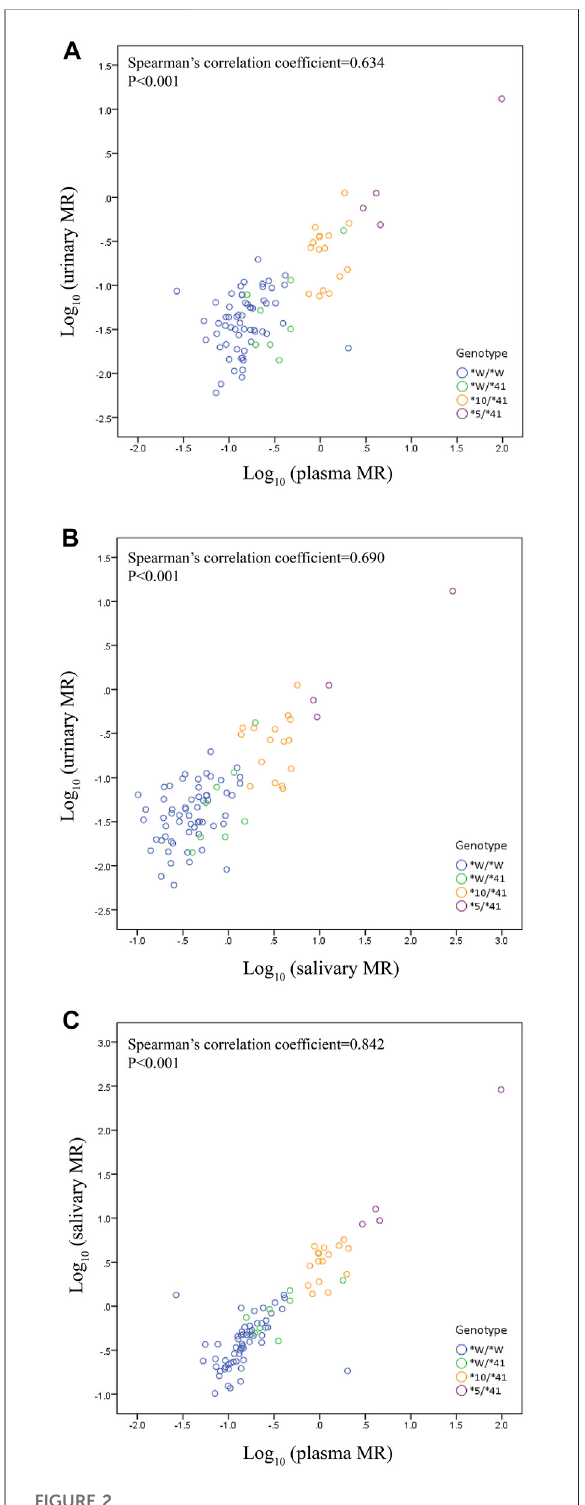
FIGURE 2 Correlations among urinary, plasma and salivary MRs in the wild type ( CYP2D6*1 / *1 , *1 / *2 , *2 / *2 ) and the three CYP2D6*41 allele relevant genotypes, respectively, in double logarithmic coordinates. Allele *W represents CYP2D6*1 or *2 . (A)